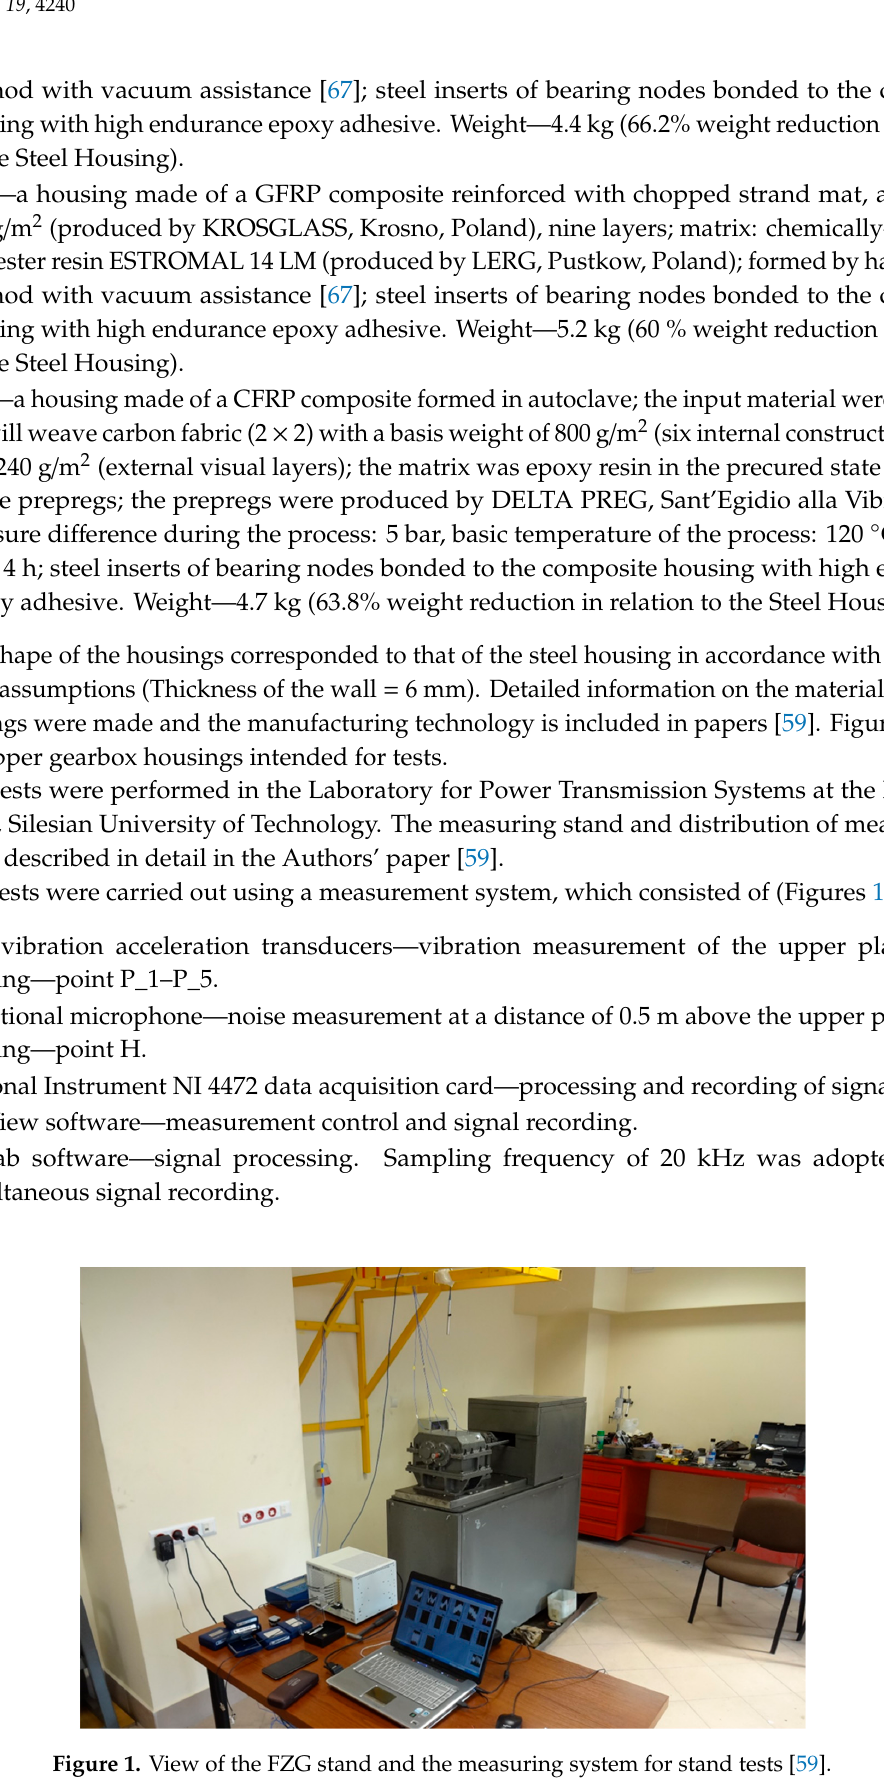
( d ) Figure 2. View of housings mounted on the stand together with measuring transducers [59]: ( a ) Steel housing; ( b ) K_1 housing; ( c ) K_2 housing; ( d ) K_3 housing. Figure 3 shows the arrangement of the points of induction and measurement of vibration and noise.